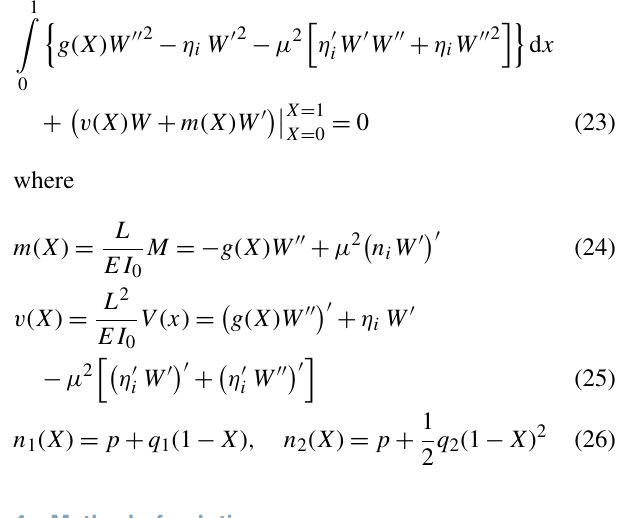
Nondimensional form of Eq. (16) can be expressed as